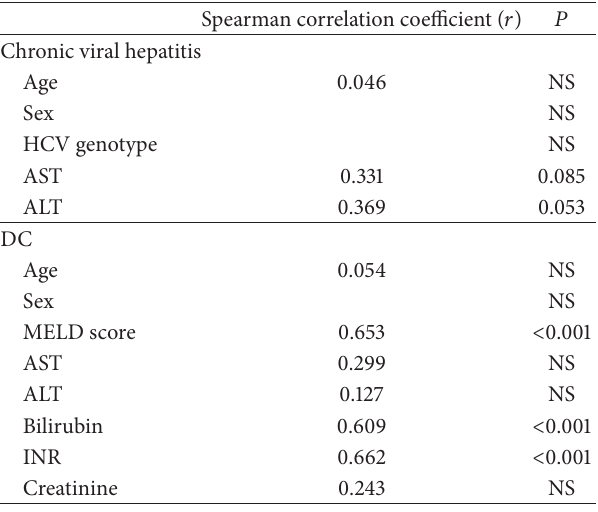
Table 2: Correlation of sDcR3 with patient characteristics. Spearman correlation coefficient ( 𝑟 ) 𝑃